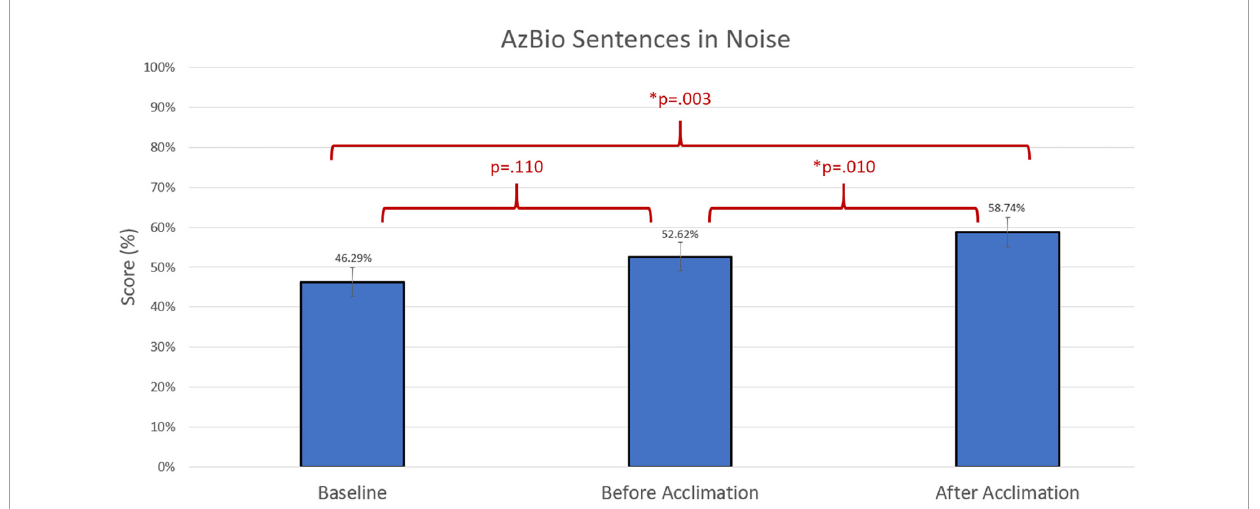
FIGURE5 Comparison of average group performance on AzBio Sentences in noise using the baseline and experimental program before and after the acclimation period.